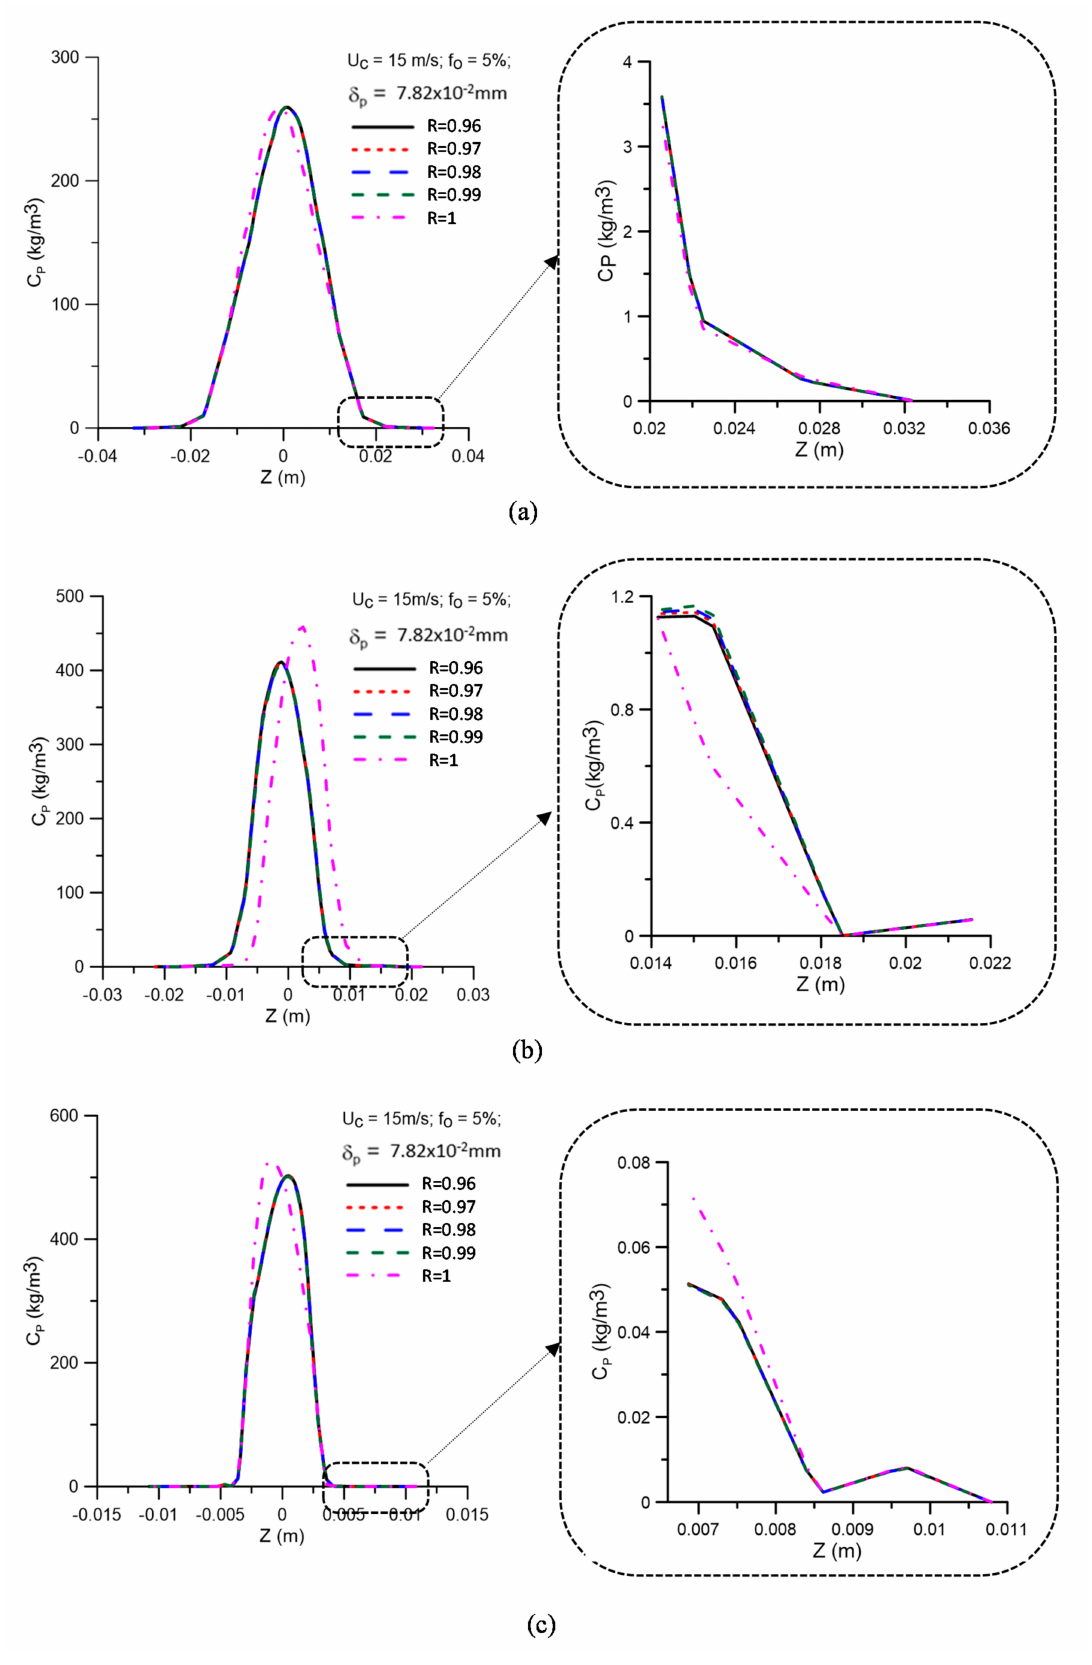
Figure 9. Oil concentration profiles for different values of the membrane rejection coefficient in the positions: ( a ) y = 0.15 m; ( b ) y = 0.45 m, and ( c ) y = 0.75 m, with δ p = 7.82 × 10 − 2